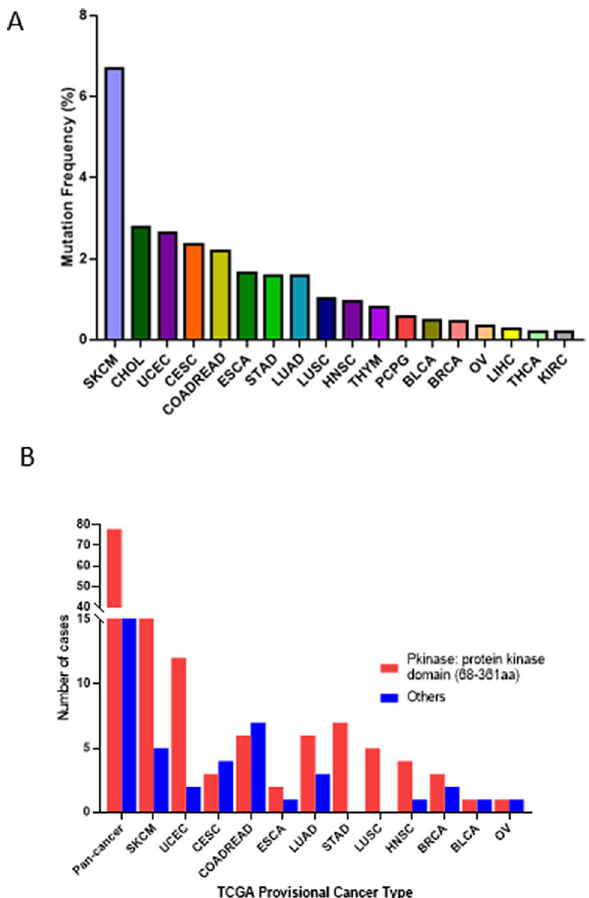
Figure 2. The mutation frequency and distribution of MEK1 in pancancer. ( A ) MEK1 mutation frequency in pancancer. ( B ) MEK1 mutation distribution belonging to different functional domains for all and the top 12